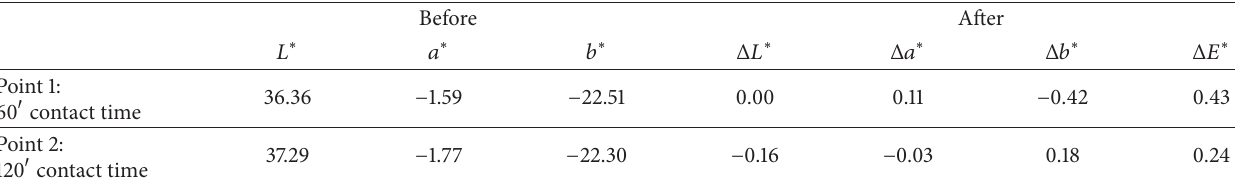
Table 2: Change in color (CIE 𝐿 ∗ 𝑎 ∗ 𝑏 ∗ system) of the cotton mockup dyed with indigo upon extraction with the Ag-agar gel added with the leuco